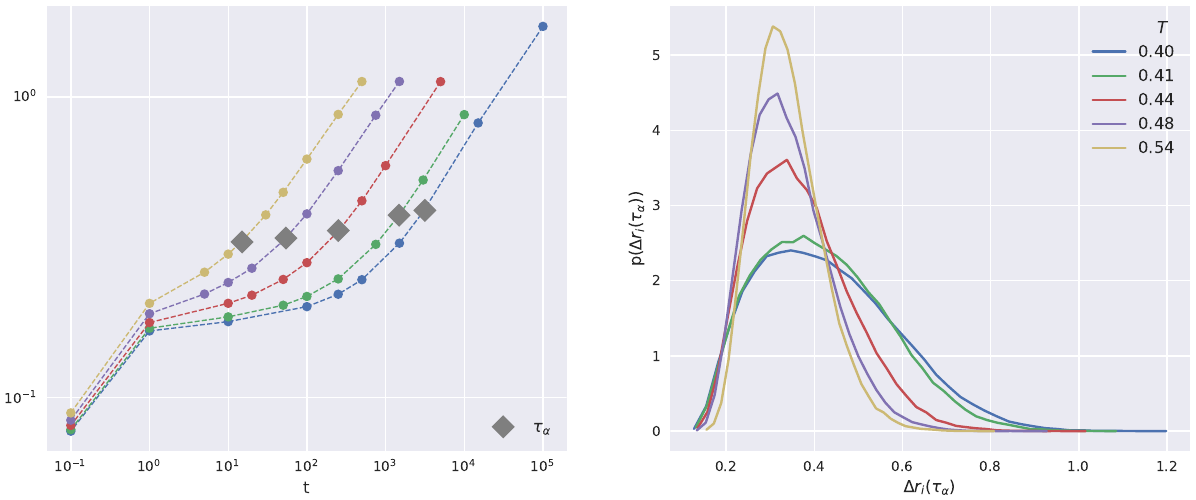
Figure 2. ( Left ) panel: Time-behavior of the particle and ICEs-averaged propensity for all the investigated state points. ( Right ) panel: Probability density function of the particle propensity ∆ r ( τ α ) i